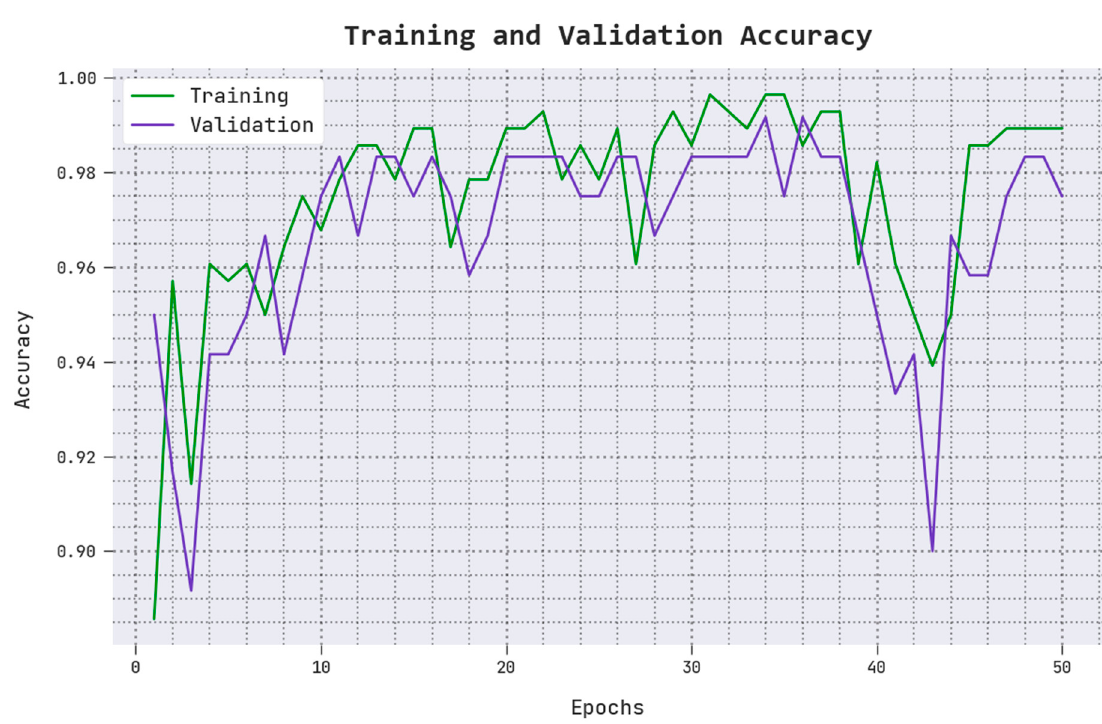
Figure 6. TACC and VACC analytical results of the AOADLB-P2C system.